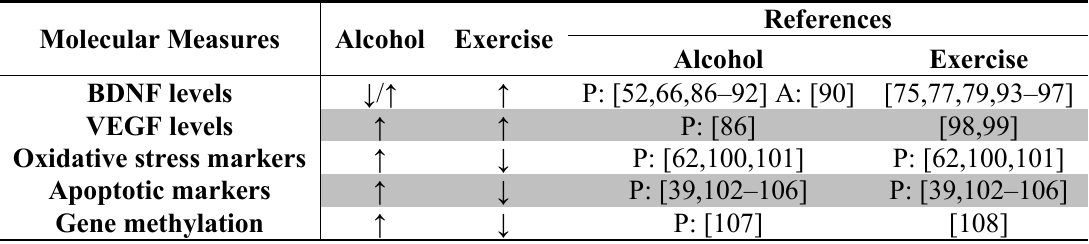
Depression-like behaviors